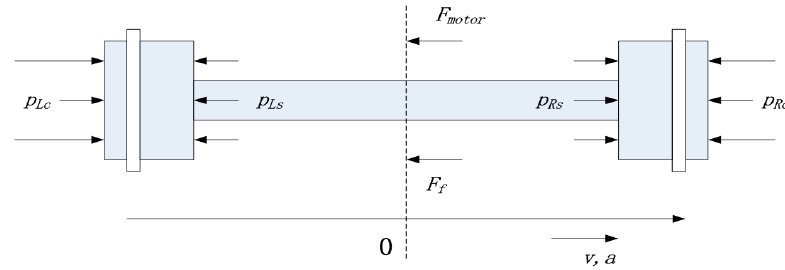
Figure 3. Free body diagram of the free ‐ piston engine mover.